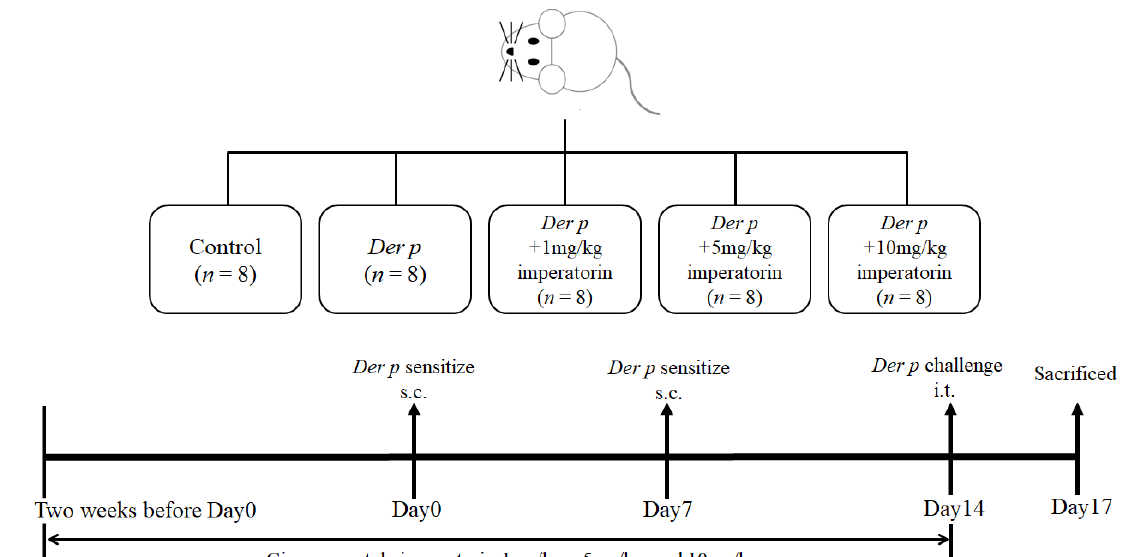
Figure 7. Schematic of the allergic sensitization and challenge protocol.